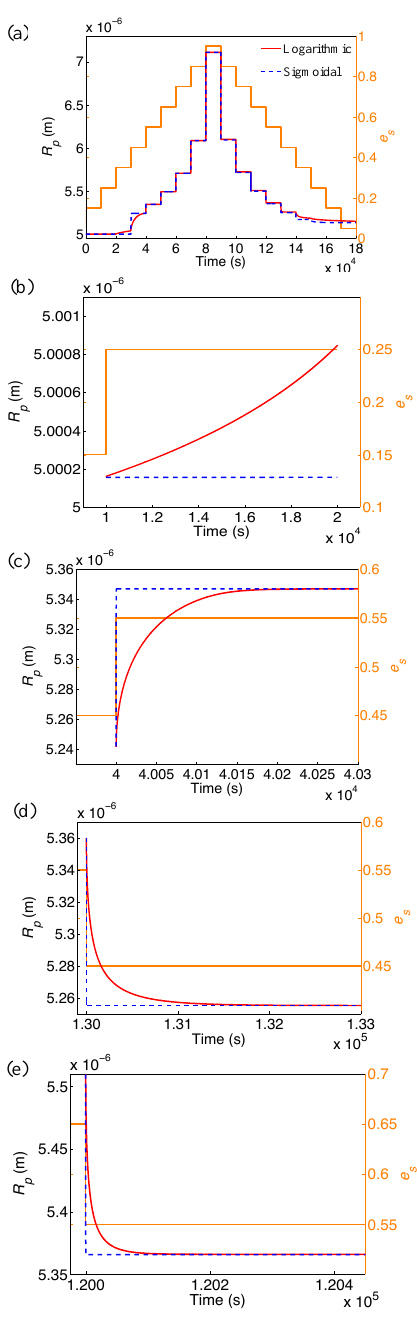
Figure 7. (a) Radius ( R p ) change with time for a single particle ex- periencing the changes in saturation ratio of the semi-volatile com- ponent ( e s ) shown by the orange curve (allied with the right vertical axis), for D 0 sv = 2 × 10 − 9 and D 0 nv = 1 × 10 − 25 m 2 s − 1 and using the D i dependencies given in the legend. (b–e) Time intervals of (a) over select changes in e s (as shown by their orange curve and right vertical